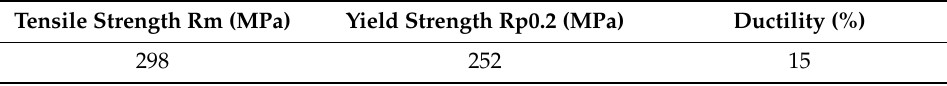
Table 3. Mechanical properties of C12200 copper.